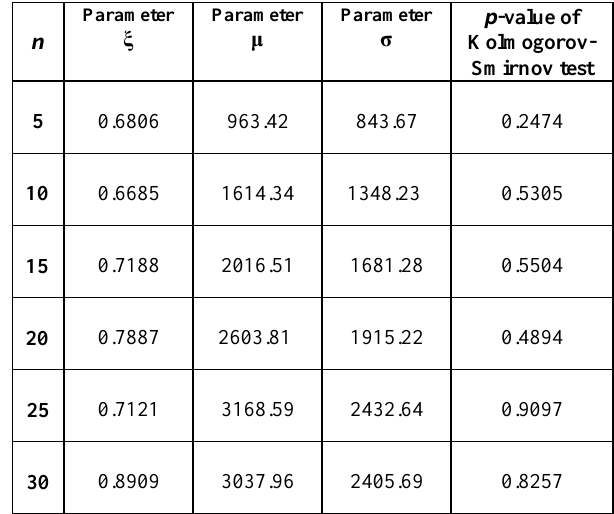
Table 4. Results of block maxima modelling.